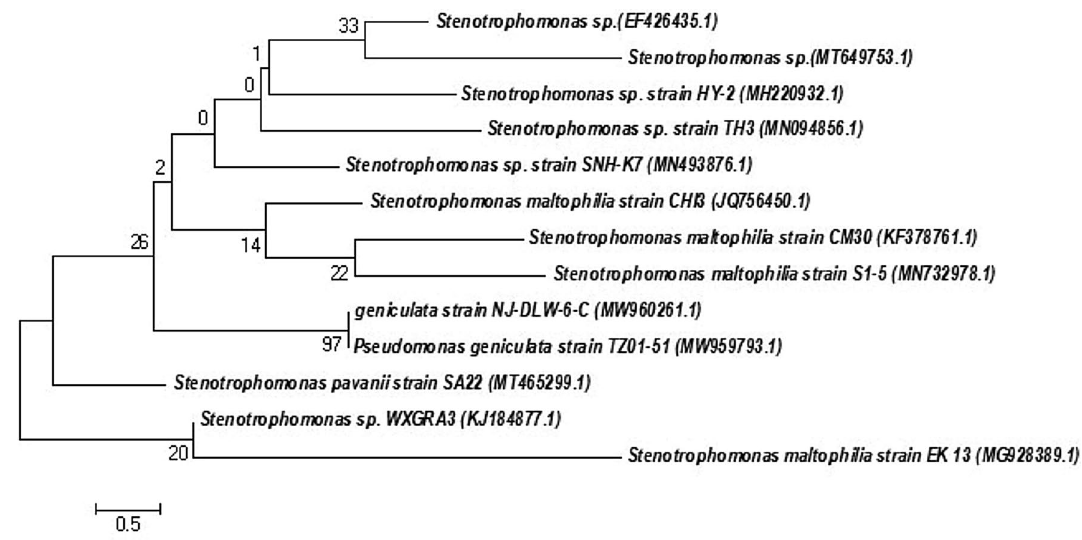
Figure 1. Phylogenetic tree of potent bacterial strain Stenotrophomonas maltophilia